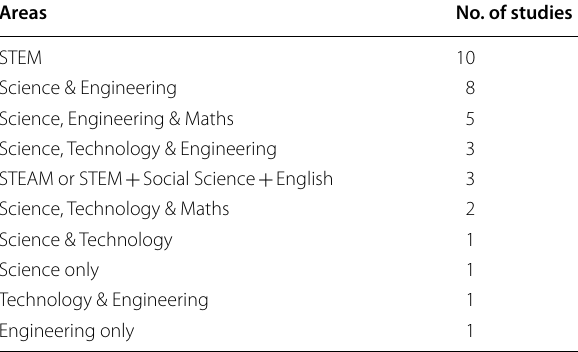
Table 2 Areas integrated in the